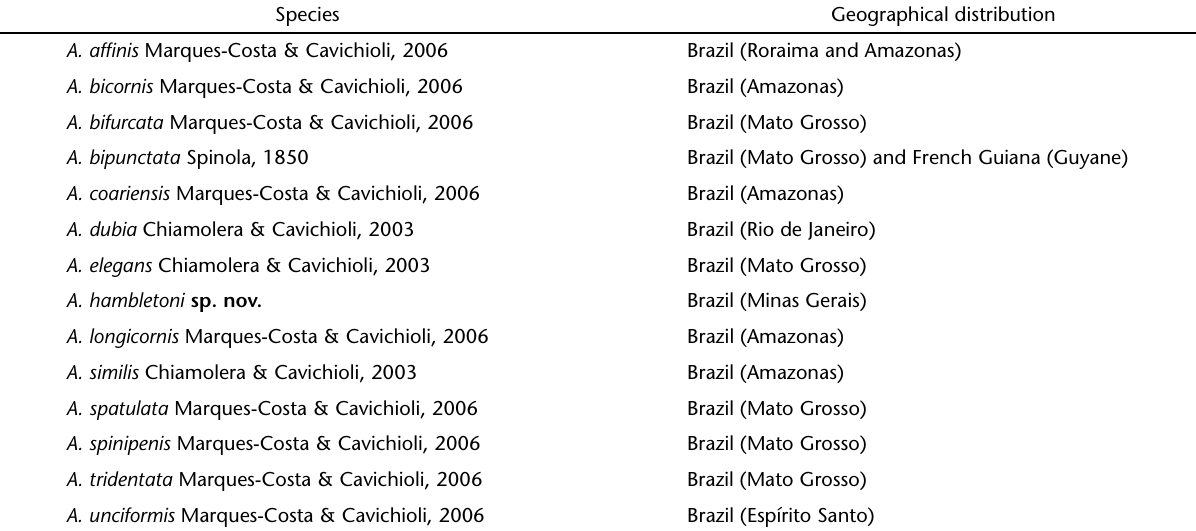
Table I. Species included in Aglaenita and their known geographical distribution (Brazilian states and French Guiana department inside parenthesis). Species Geographical